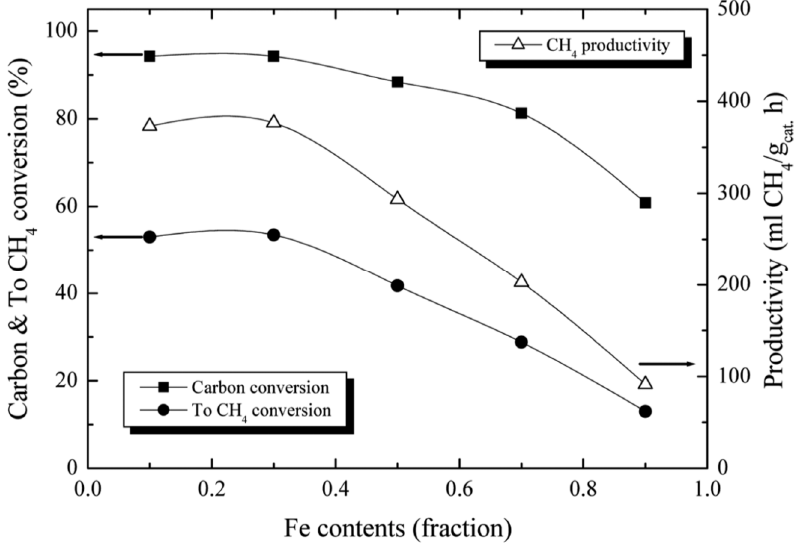
Figure 15. Carbon conversion and CH 4 productivity on Ni 1 − x Fe x / Al 2 O 3 catalysts according to Fe contents [102].